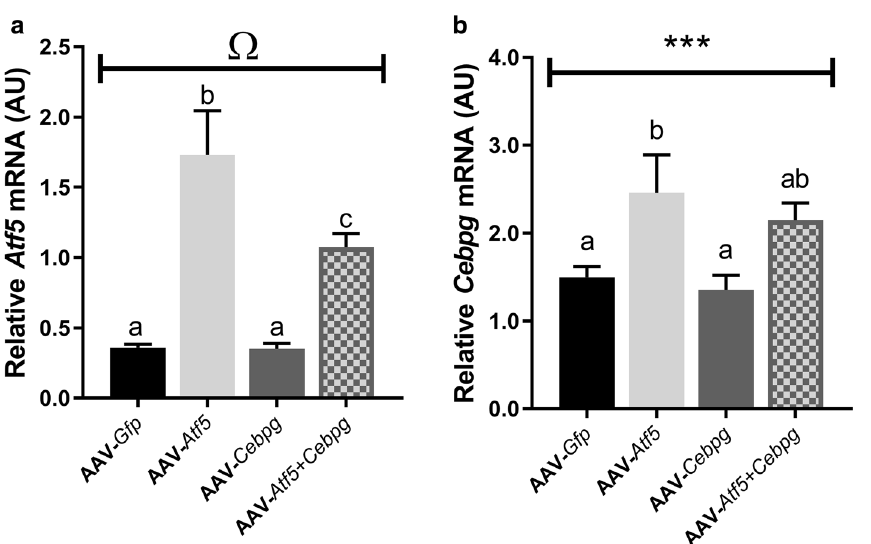
Figure 6. Validation of AAV-mediated overexpression of Atf5 and Cebpg individually and in combination (AAV- Atf5 ± Cebpg ) at the mRNA level. Relative mRNA expression of ( a ) Activating transcription factor-5 ( Atf5 ) and ( b ) CCAAT/enhancer binding protein gamma ( Cebpg ) were determined in the Extensor Digitorum Longus (EDL) muscle following 28 days AAV-mediated overexpression. mRNA expression data was normalised to OliGreen, as a measure of total cDNA. Data presented as Means (n = 8, except n = 24 for AAV- Gfp ) ± SEM. Ω indicates a trend ( P = 0.08) for an AAV- Atf5 × AAV- Cebpg interaction. Different letters indicate significant differences ( P < 0.05). *** P < 0.001 indicates significant effect of AAV- Atf5 (with or without Cebpg